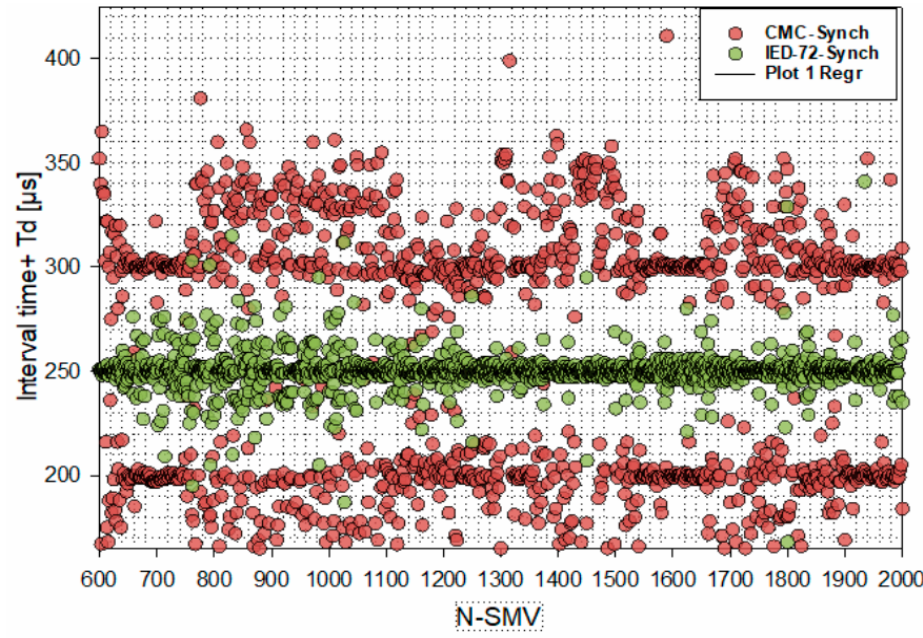
Figure 12. The interval time + delay time in µsec between publisher/subscriber (CMC & IED-72).